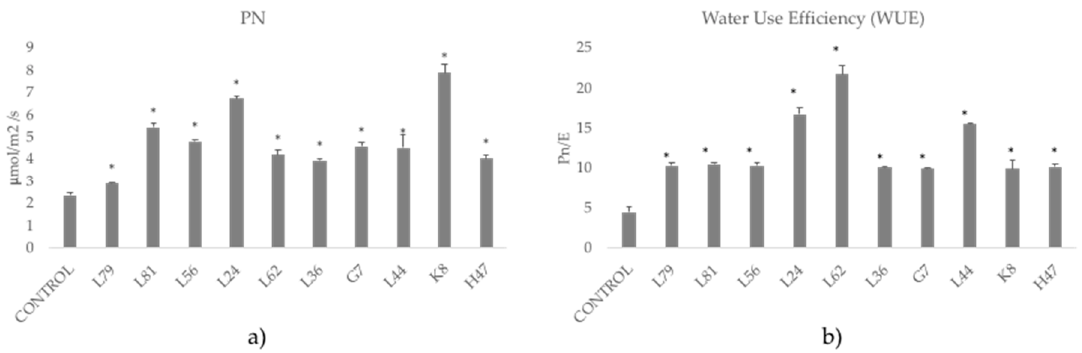
Figure 3. Photosynthetic parameters related to C fixation measured in olive tree plants treated with the ten strains. ( a ) Net photosynthesis (PN) measured as the CO 2 fixed by the leaves (μmol CO 2 /m 2 s). ( b ) Water Use Efficiency (WUE) calculated as PN divided by transpiration rate (μmolH 2 O /m 2 s). Average values of the replicates with standard error bars are represented ( n = 6). Asterisks (*) represent significant differences with the control according to the LSD test ( p < 0.05).